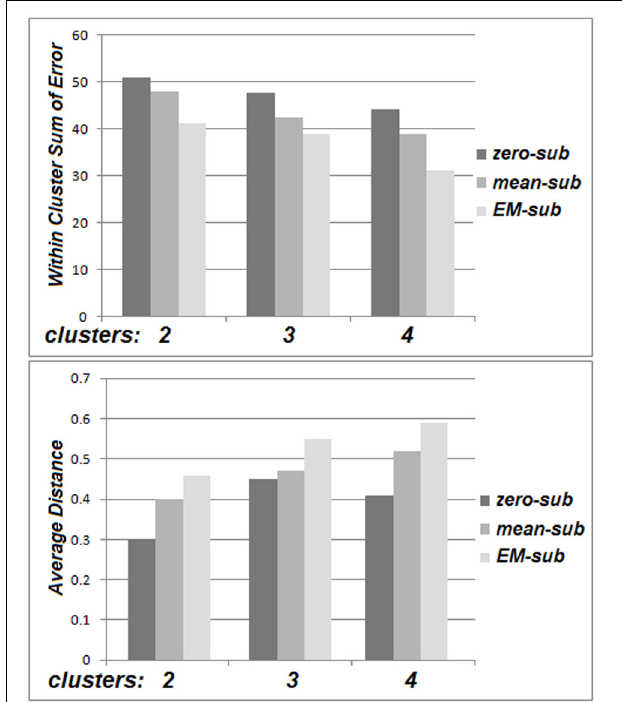
FIGURE 5 | The within cluster sum of squared errors (top) and average distance between cluster centers for the Go No/Go dataset (bottom).